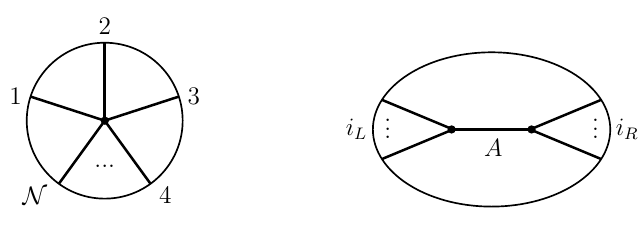
Figure 1 . Left: N -point bulk contact diagram. Right: arbitrary-point bulk exchange diagram. underlying space which is itself a tree), one important class of which is contact